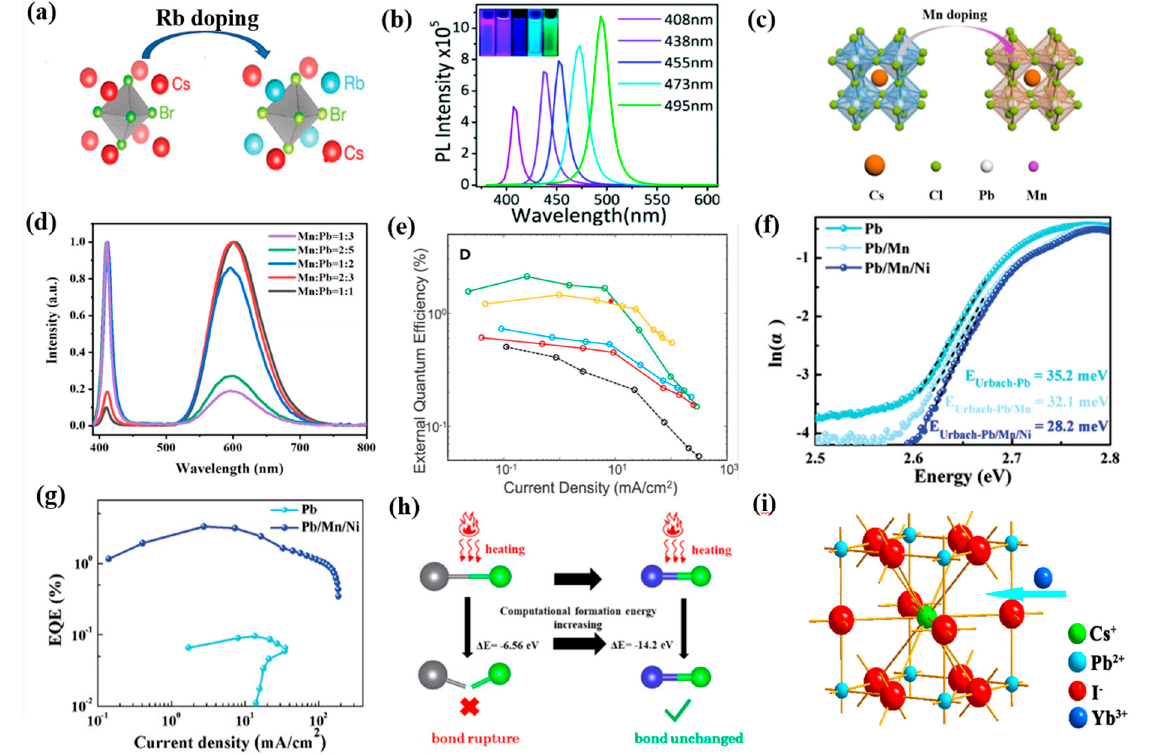
Figure 3. ( a ) Schematic diagram of Rb doping. Reproduced with permission from Ref. [61]. Copy- right American Chemical Society, 2019. ( b ) The PL spectra of Eu 3+ –doped Cs x K 1 − x PbCl y Br 3 − y QDs.